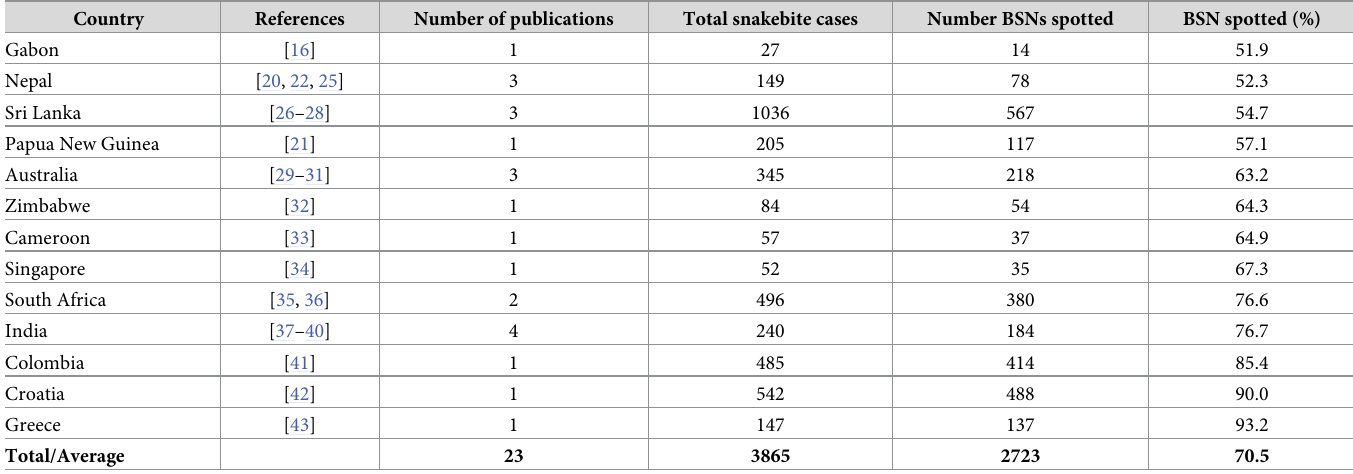
Table 2. Number of snakebite cases where the BSN was spotted by the